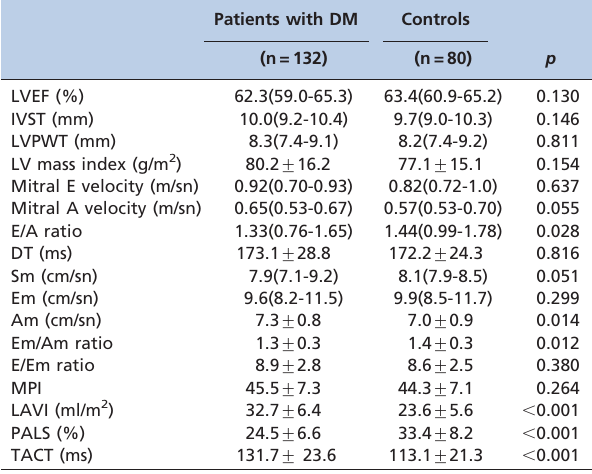
Table 2 - Echocardiographic characteristics of the study